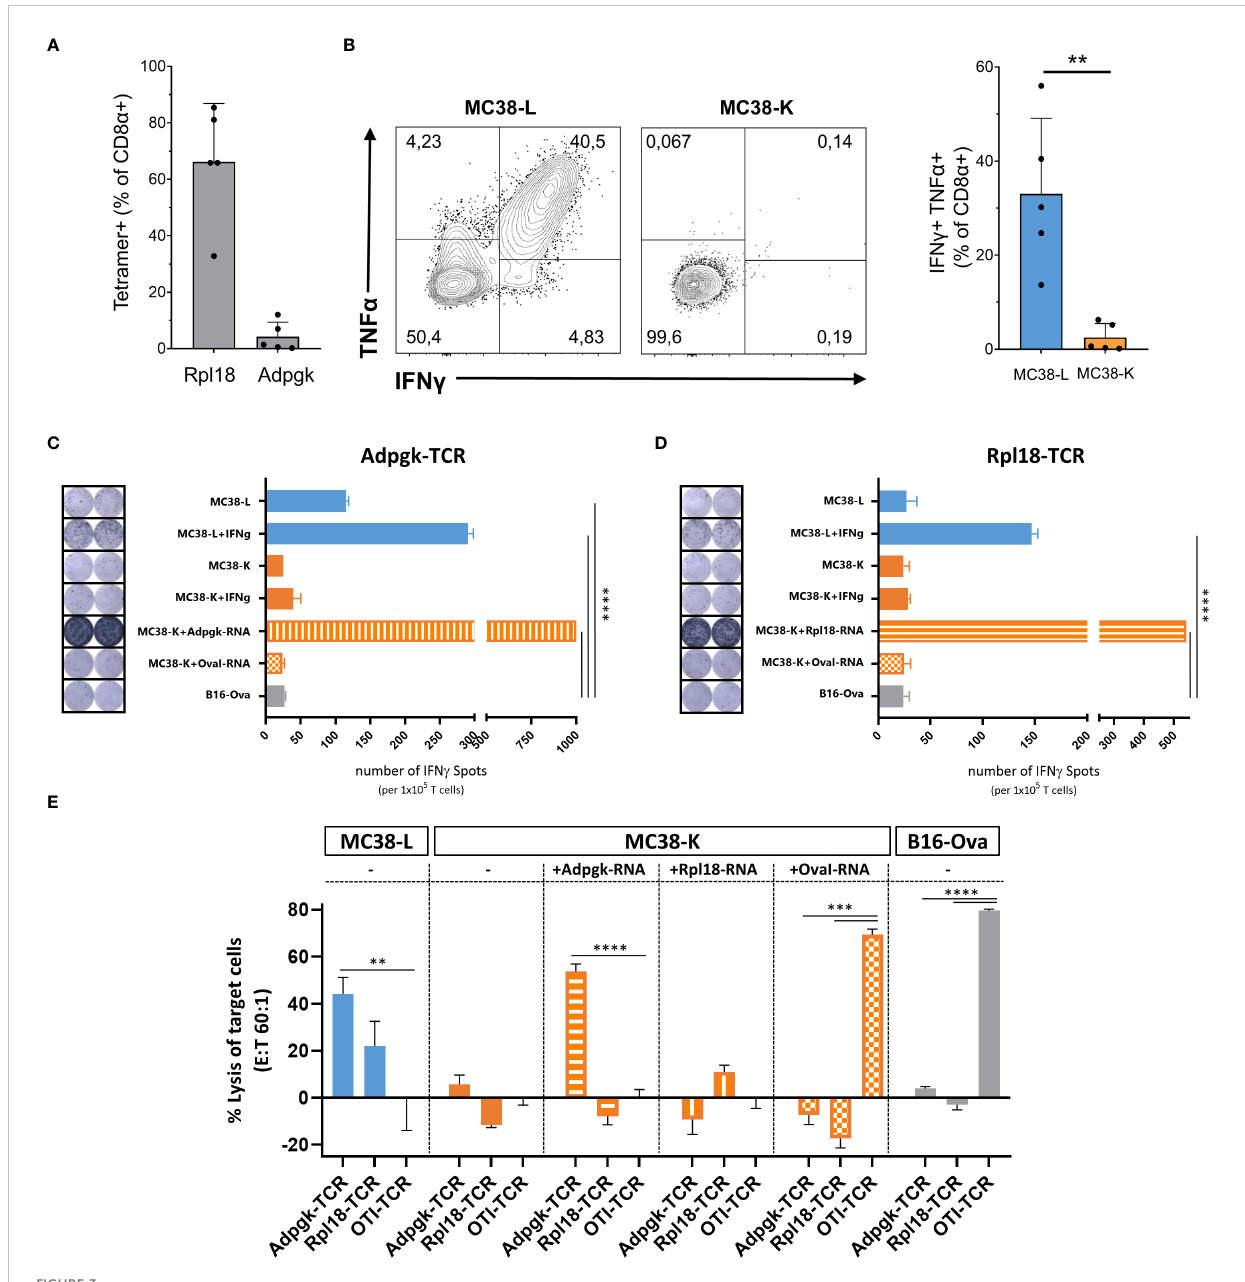
FIGURE 3 Comparison of MC38-L and MC38-Kcell lines on immunogenic level. (A) Antigen speci fi cities of established CD8+ T cell lines were analyzed by Rpl18 and Adpgk speci fi c tetramers. (B) Established CD8+ T cell lines were analyzed for recognition of MC38-L or MC38-K tumor cells by induced cytokine production after coculture with live tumor cells. IFN g secretion by Adpgk-TCR (C) or Rpl18-TCR (D) transduced T cells upon co-culture with different tumor cells via ELISPOT assay. Data indicate mean ± SD of biological replicates (n=2). P values determined by One-way ANOVA Tukey´s multiple comparison test. (E) In vitro cytotoxic activity of Adpgk-TCR or Rpl18-TCR transduced T cells after 12h co-culture with different tumor cells. Data indicate mean ± SD of biological replicates (n=3). P-values were determined with respect to OTI-TCR control by One-way